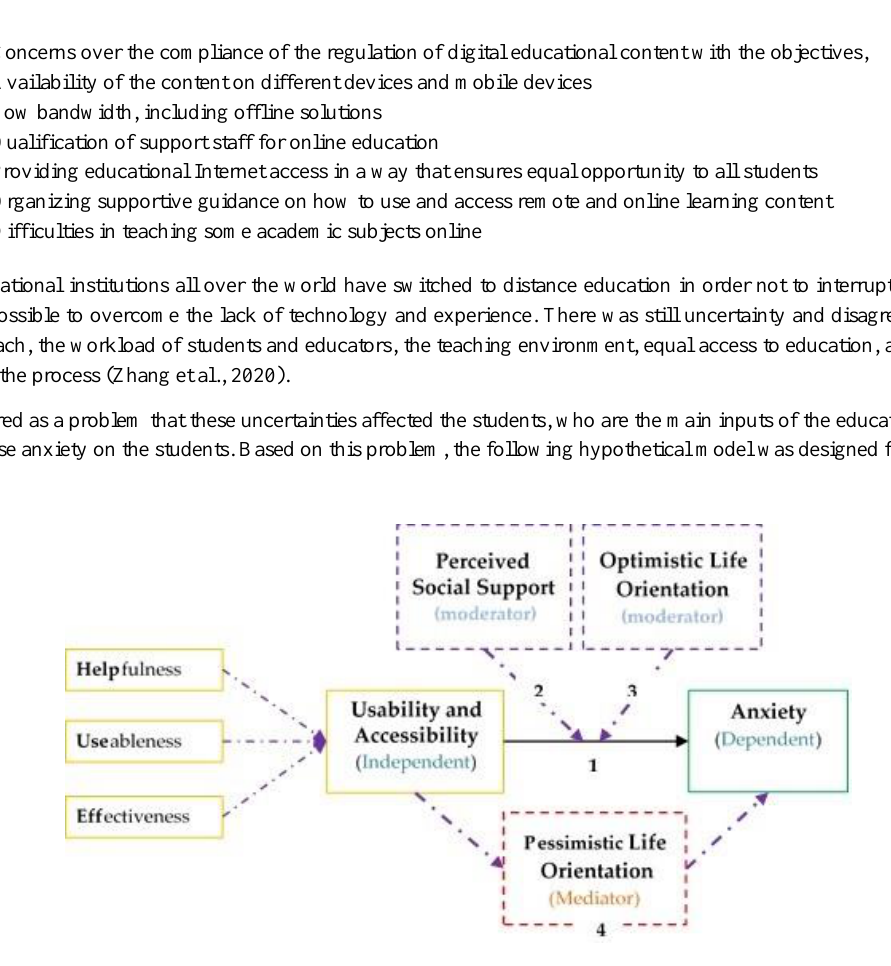
Figure 1: The hypothetical model designed for the